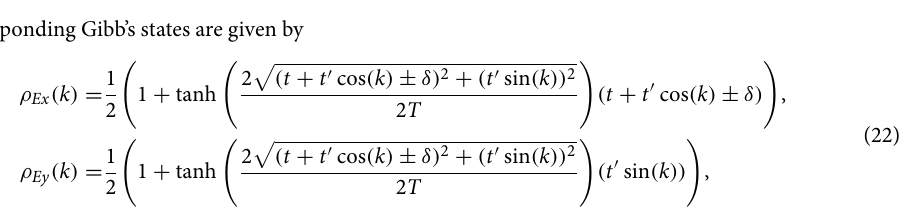
0 , the EWVs encircle the origin once in both parameter space for W At T = 1 / 2 , the EWVs encircle the origin of only one parameter space as shown in Fig. 3b3,b4. With the intro- W = duction of arbitrary temperature, the curve starts shifting towards one end of the parameter space. The higher temperature may destroy the topological properties of the system. The Uhlmann phase is given by Eq. (10), which becomes equal to Berry phase in the pure state limit T